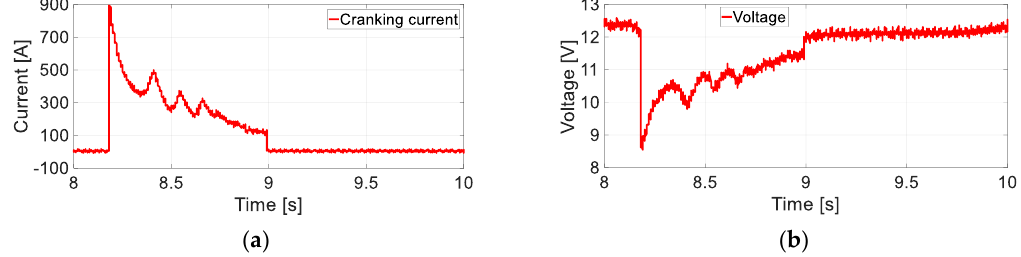
Figure 1. Diagram of: ( a ) cranking current; ( b ) battery voltage during Volkswagen 1.9 TDI 107 BHP start-up in standard conditions; T = 293 K.